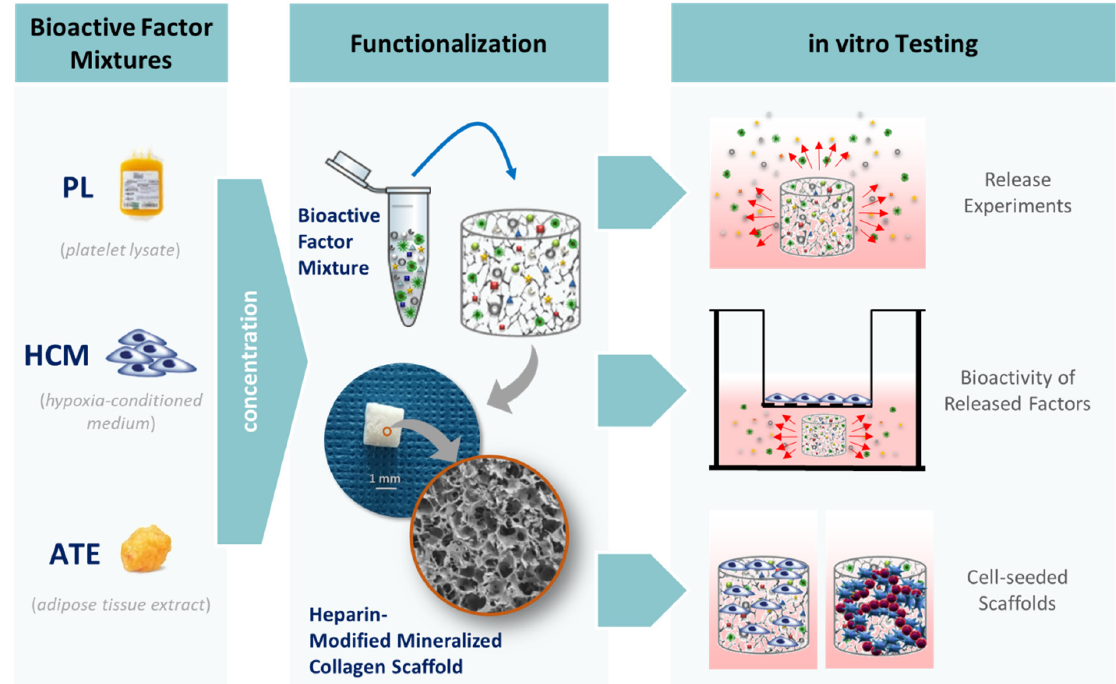
Figure 1. A schematic diagram of the different experiments. Bioactive factor mixtures were produced from platelet lysates (PL), conditioned medium from hypoxia-treated human telomerase immortalized bone marrow-derived mesenchymal stem cells (HCM) and adipose tissue extracts (ATE). Following functionalization of heparin-modified mineralized collagen scaffolds, release kinetics, the bioactivity of the released factors and the response of directly seeded cells were investigated.